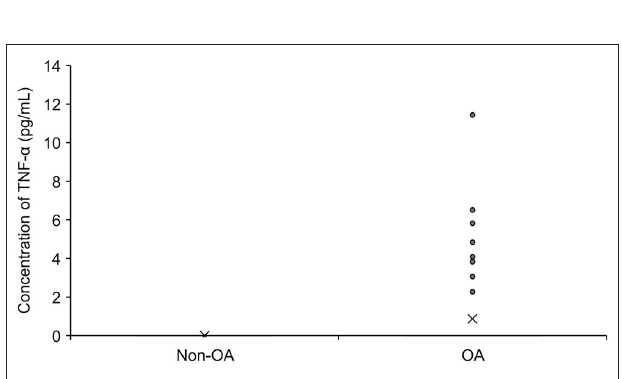
FIGURE 3 | The concentration of TNF- α in synovial fluid in dogs with OA ( n = 69) and without OA ( n = 79). The mean value is denoted as ‘x’. OA: osteoarthritis.